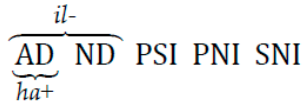
Figure 4. Reference Hierarchy for Egyptian.